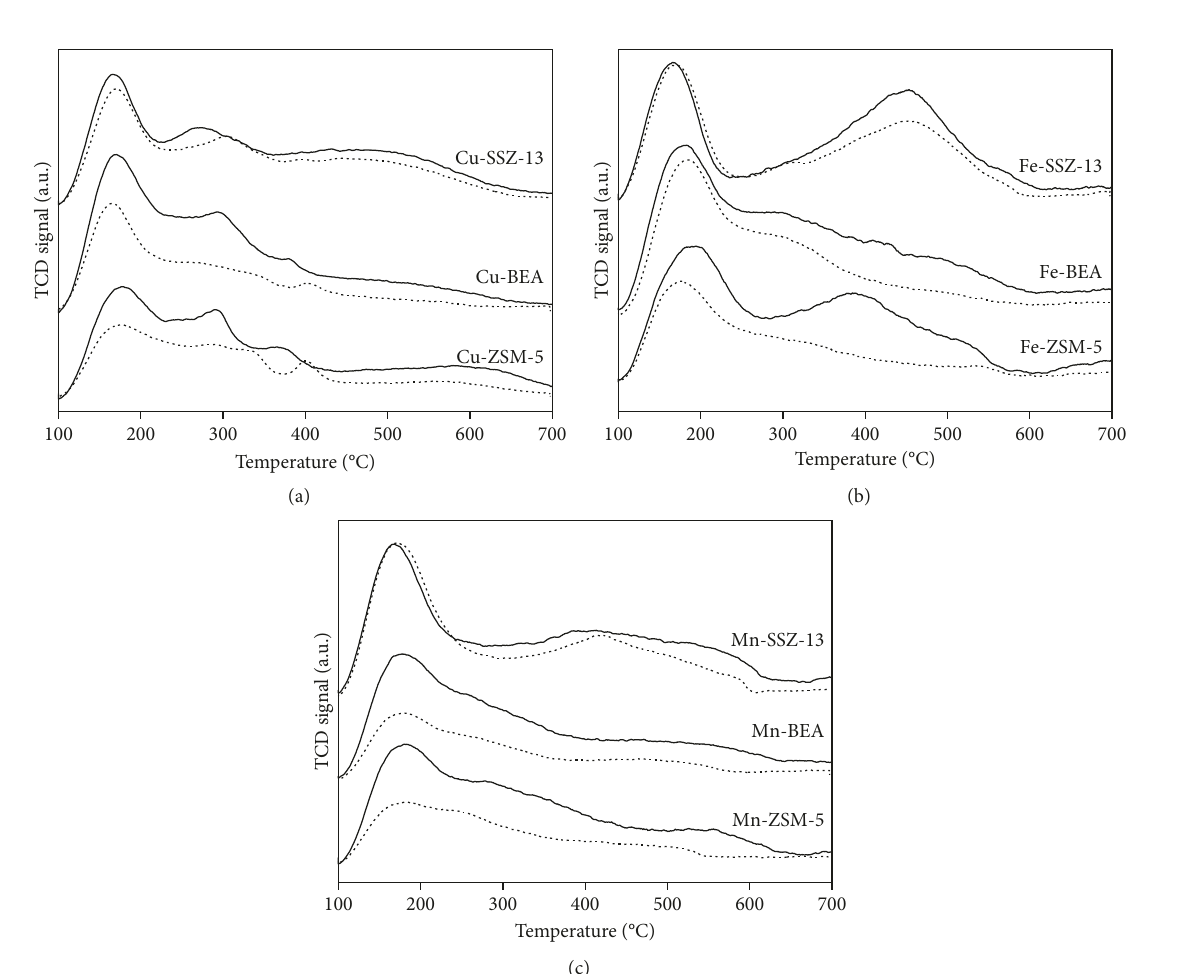
Figure 2: NH 3 -TPD profiles of fresh and hydrothermally treated (dotted line) (a) Cu-, (b) Fe-, and (c) Mn-zeolite